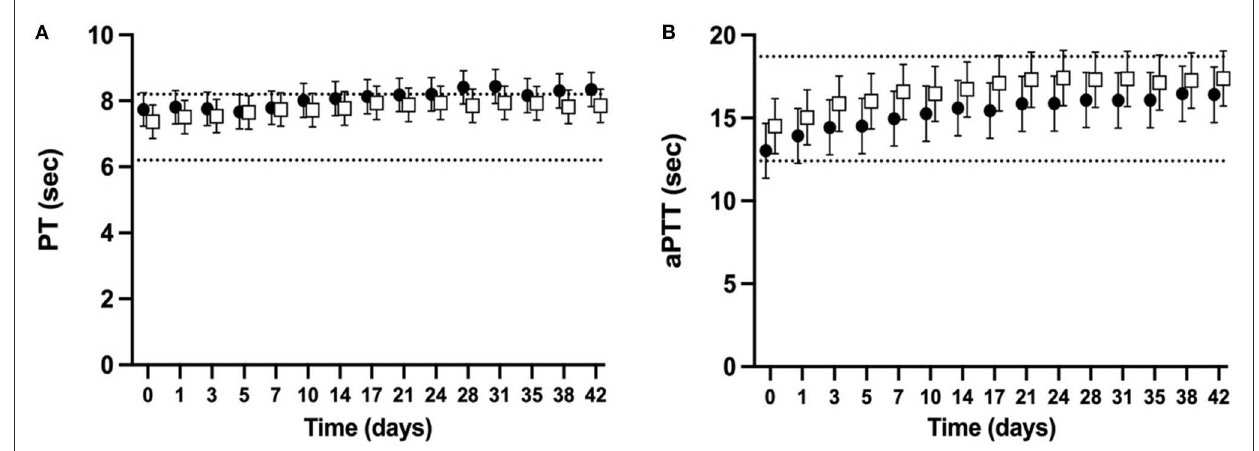
FIGURE2 Serial estimated marginal means and 95% confidence intervals for prothrombin time (PT; A ) and activated partial thromboplastin time (aPTT; B ) of whole blood from non-greyhound ( • ) and greyhound ( (cid:3) ) dogs cold-stored for 42 days. The dotted lines represent the published reference interval for citrated plasma from dogs of a mix of breeds using the ACL-TOP ® 300 CTS (37).